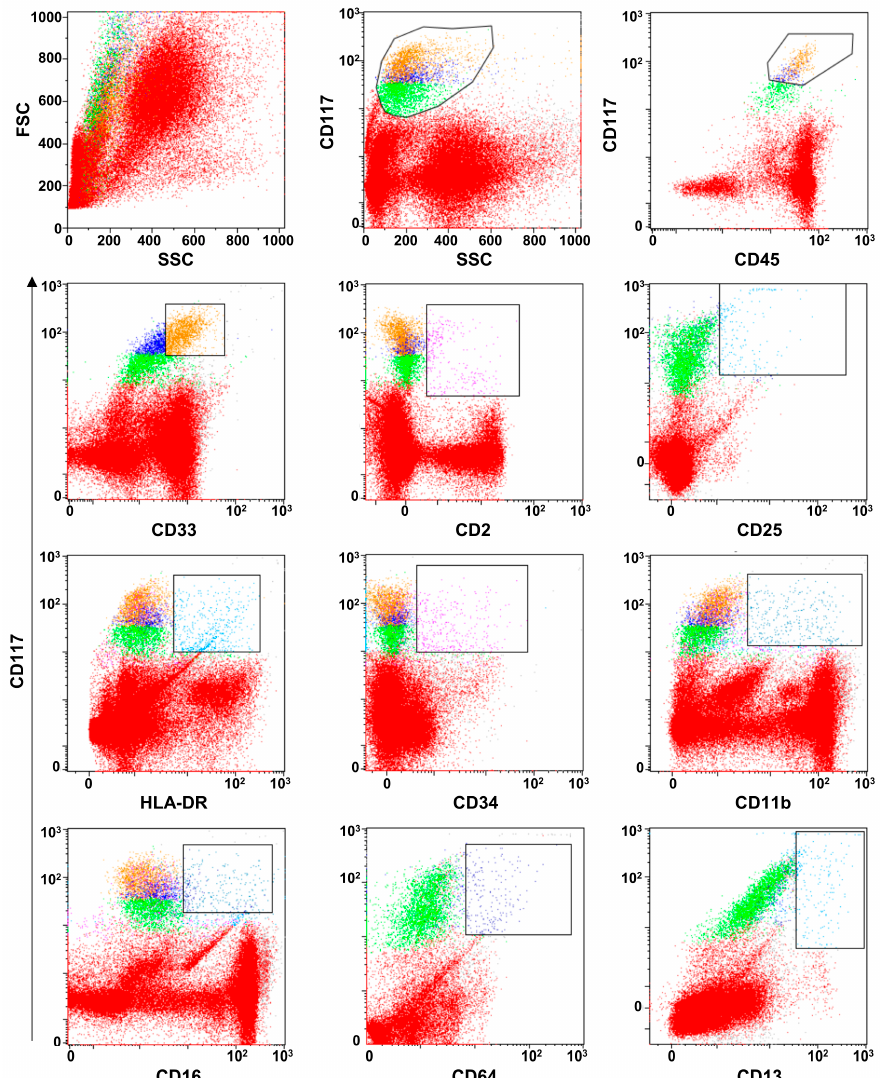
Figure 2. Flow cytometry gating strategy for MC immunophenotyping. MCs can be first identified as CD117 high cells with low side scattering (SSC) and CD45 high expression. On gated MCs, expression of normal markers, such as for CD33, CD16, CD11b, CD13, and CD64, of aberrant markers, including CD2 and CD25, or of increased expression of precursor makers, such as CD34 and HLA-DR, can be performed.